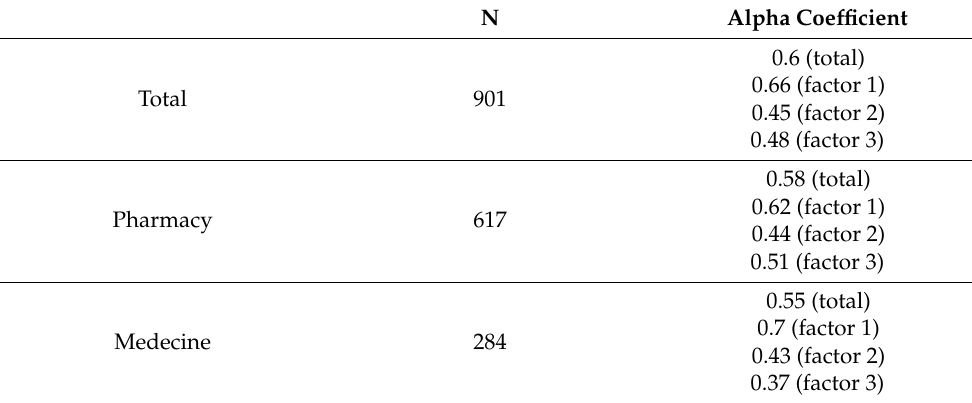
Table 8. Cronbach’s coefficients of the